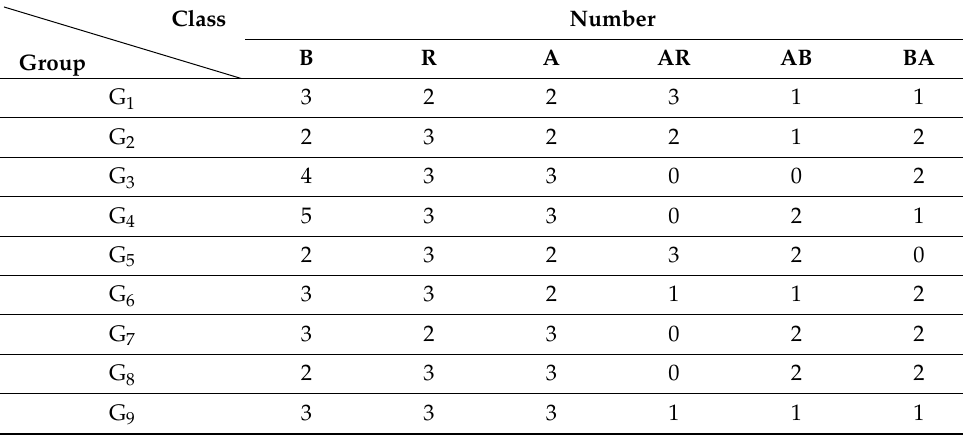
Table 6. The possible numbers of the endmember spectra in each